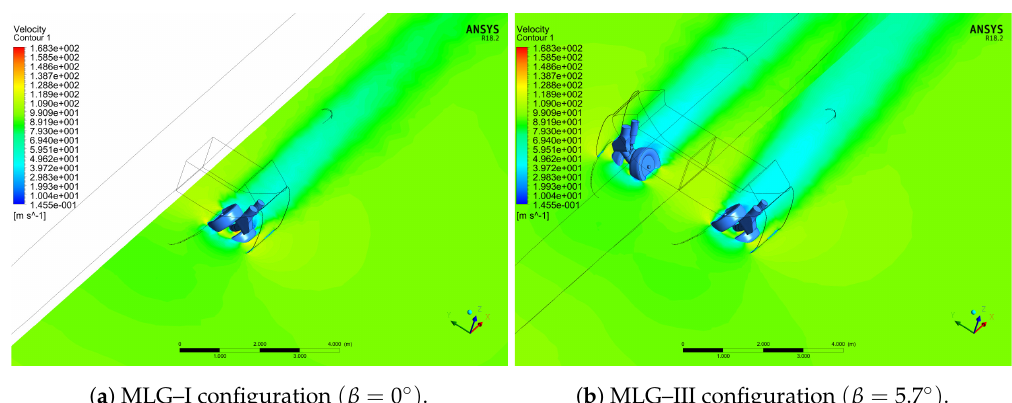
Figure 18. MLG: mean velocity contours at a given time